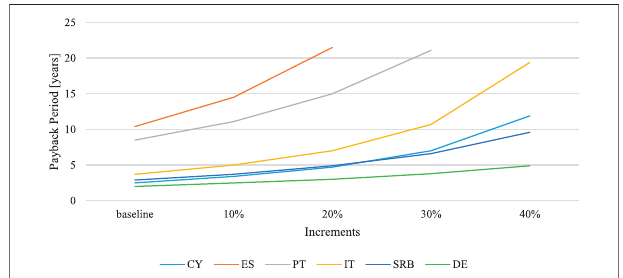
FIGURE 10 | CO 2 payback period per country for the double U-tube GSHP system (compared to ASHP), with various increments added in ASHP ef fi ciency (COP) from values presented in Figure 1 , for the GWP impact per FU.